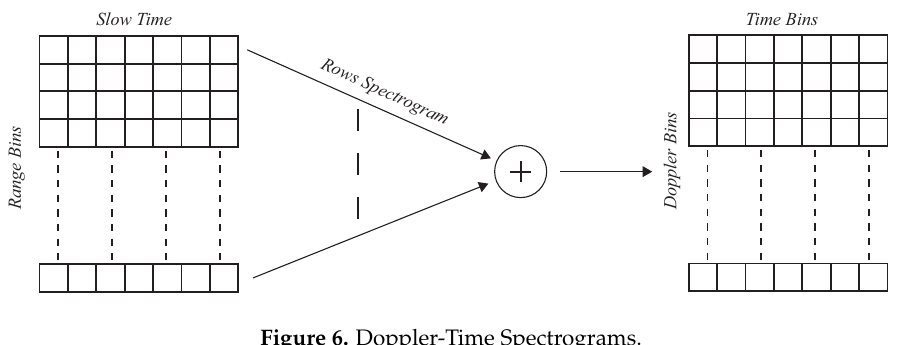
Figure 6. Doppler-Time